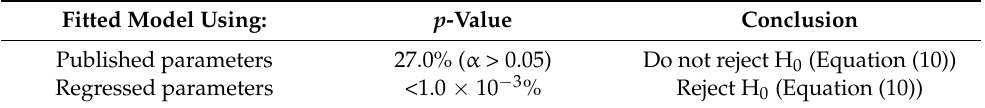
Table 2. p -Values obtained using the bootstrap